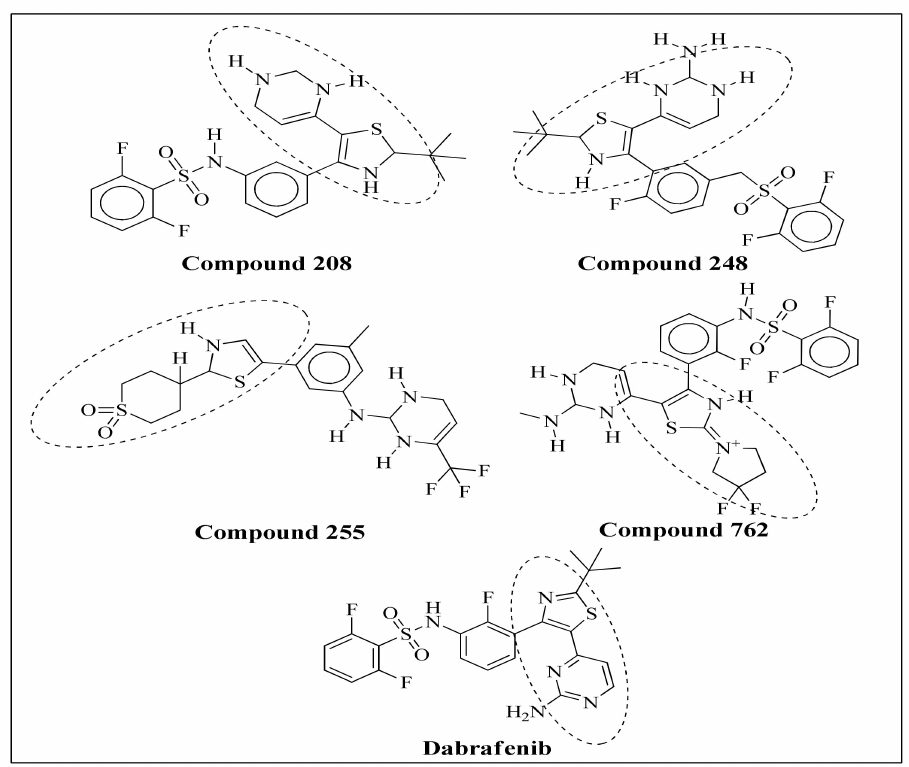
Figure 1. Top Hits obtained through SBVS. All hits were sharing same basic Pharmacophore with standard